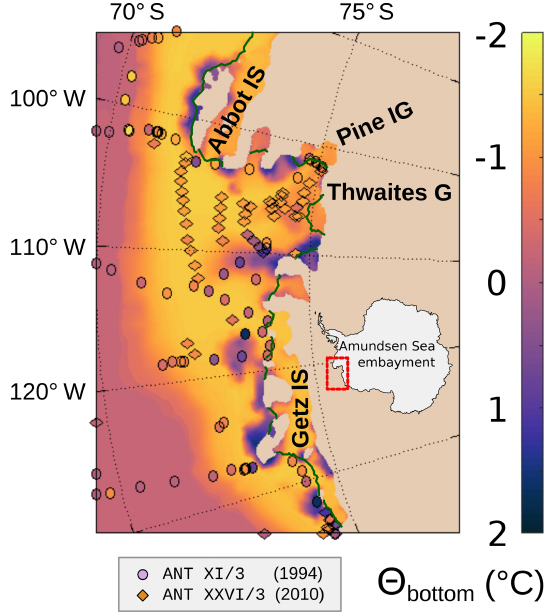
Figure 1. Modeled and observed seafloor ocean potential temper- atures ( θ bottom ) in the Amundsen Sea sector of West Antarctica. The plot shows the simulated mean ocean temperatures for the con- trol run (CTRL, years 1948–2007), while circles (ANT XI/3; Miller and Grobe, 1996) or diamonds (ANT XXVI/3; Gohl, 2010) repre- sent observed bottom temperatures taken in 1994 and 2010, respec- tively. The solid green lines follow shelf ice edges, and the inset shows the location of the area of interest as a red box.The following abbreviations are used: Abbot IS (Abbot Ice Shelf), Pine IG (Pine Island Glacier), Thwaites G (Thwaites Glacier) and Getz IS (Getz Ice